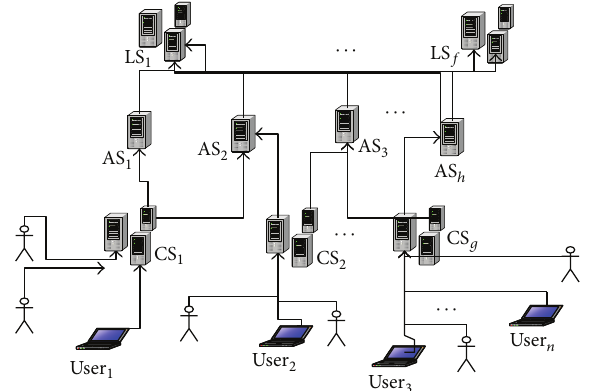
Figure 1: Location-based services system with the anonymous